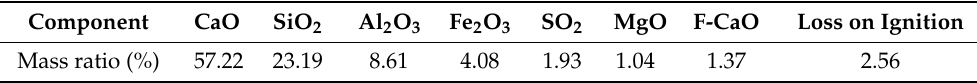
Table 1. Chemical composition of cement used in this study.